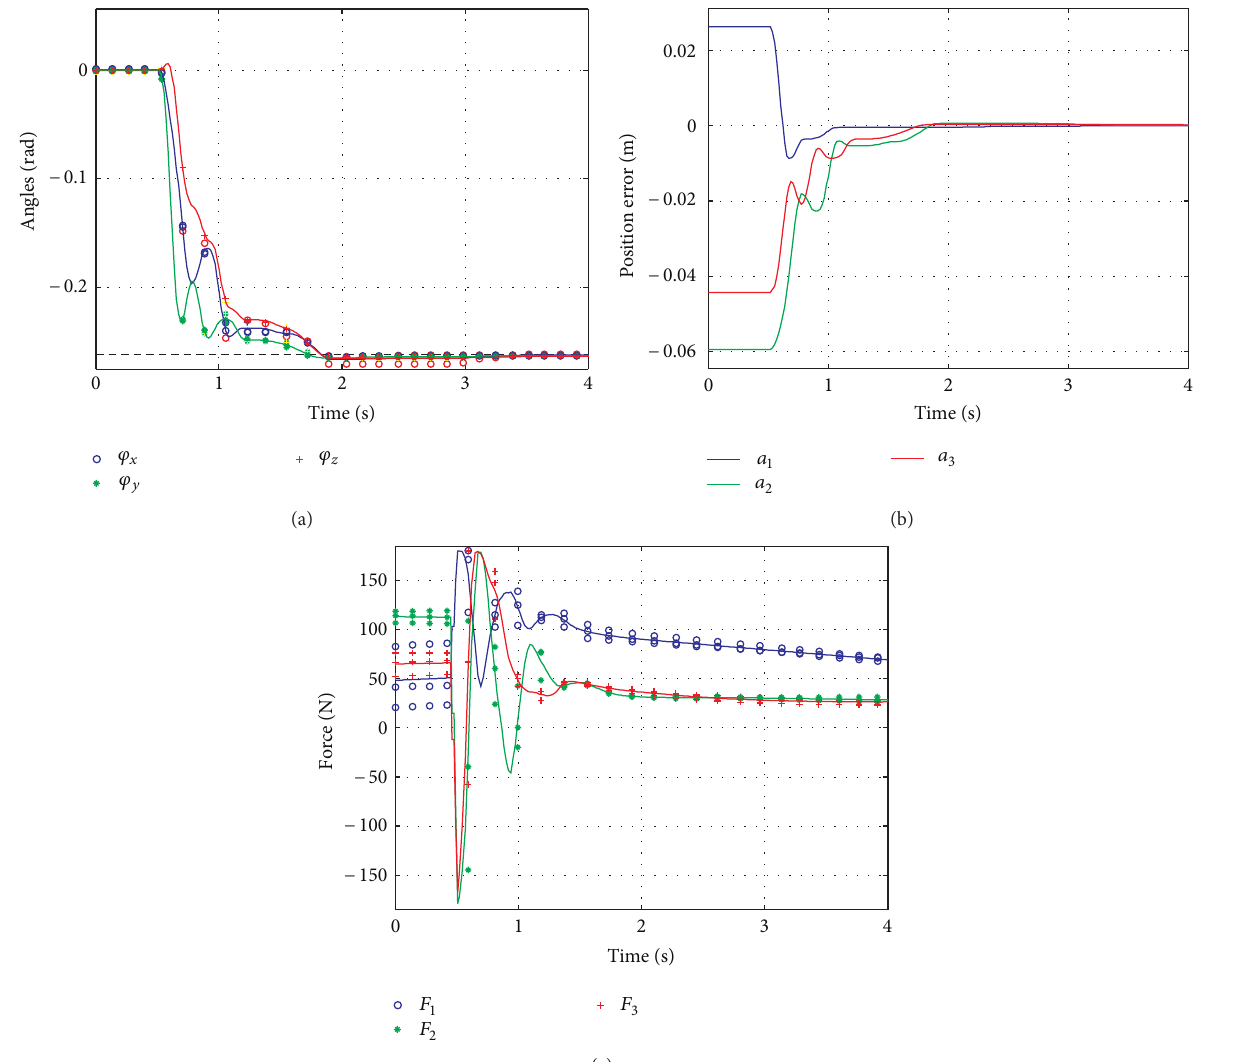
Figure 11: Joint-space PID controller: platform’s trajectory in task-space (a), joint space errors (b), and motors thrusts